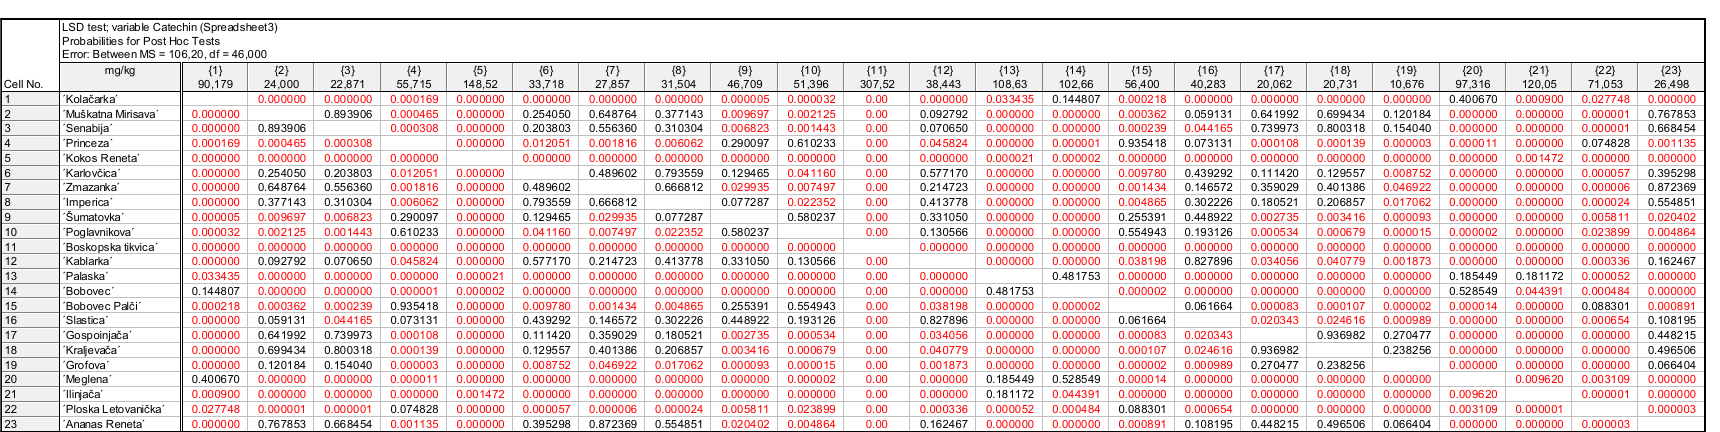
Figure A1. The statistical significance of catechin in traditional apple varieties; the p -values of the correlations of identified polyphenols. Statistically significant p -values are marked red ( p < 0.05).